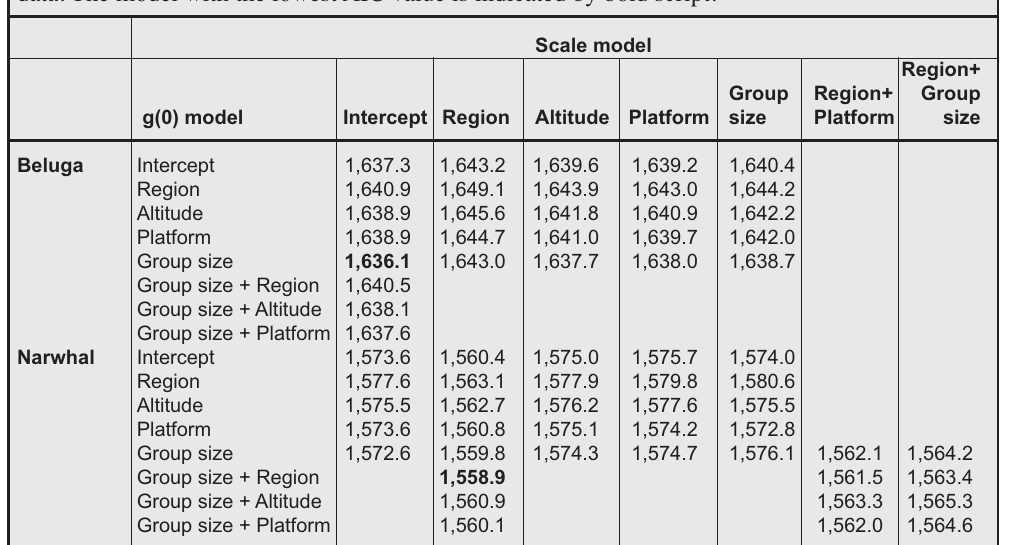
Table 4. AICc values of fitted models of detection probability for beluga and narwhal observation data. The model with the lowest AIC value is indicated by bold